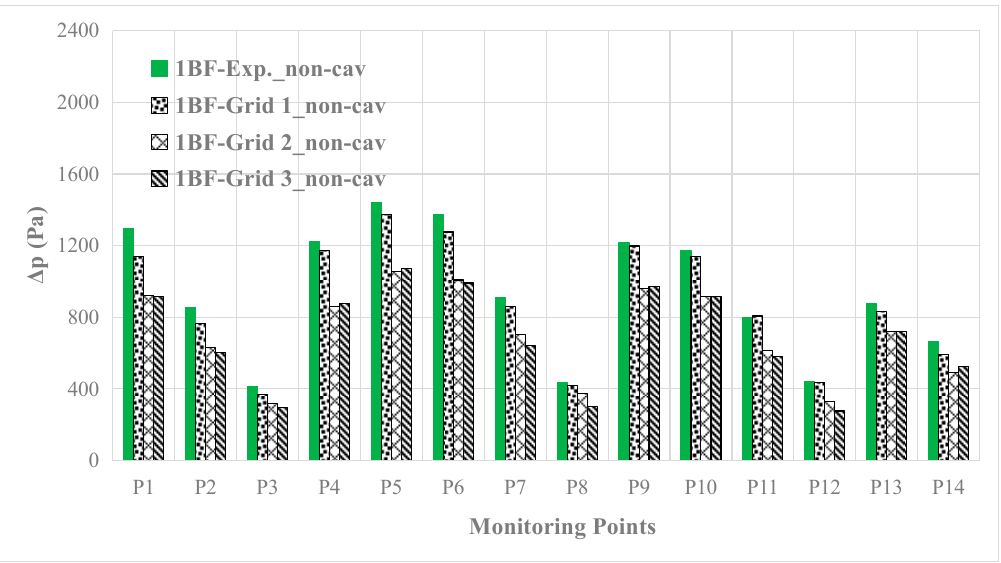
Figure 11. The 1BF (first blade frequency) component of hull pressure fluctuation predicted compared with the test data in non-cavitating condition.